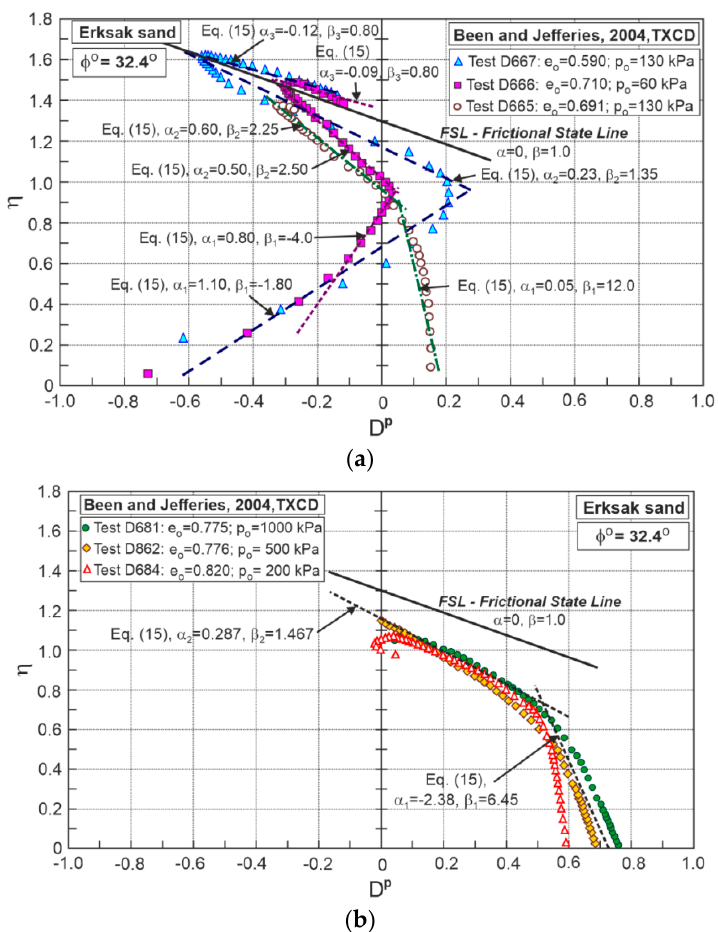
Figure 5. The relationships between the stress ratio and plastic dilatancy for Erksak sand: ( a ) dilative behavior; ( b ) contractive behavior.